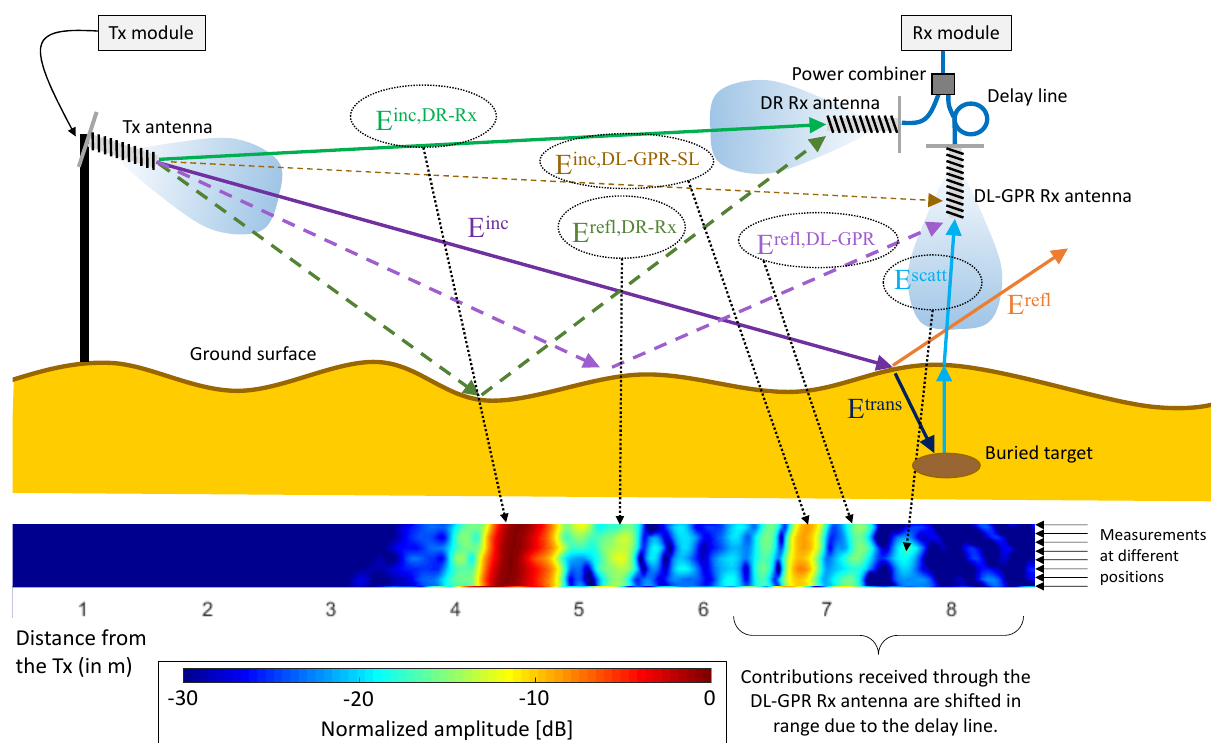
Figure 4. Scheme of the implemented hybrid FL-DL GPR system. Identification of the different received contributions in the retrieved reflectivity plotted as a function of the distance from the transmitter for several measurements.